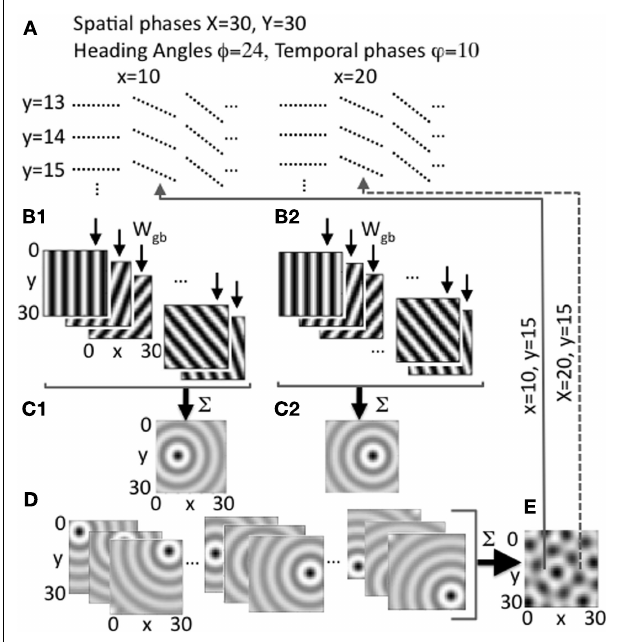
FIGURE 2 | Heading angle input across the full range of spatial phases. (A) Each spatial phase ( x , y ) is coded by a heading angle array that includes 24 different heading angles with 10 different temporal phases in each heading angle. Examples show 3 out of 24 angles for individual spatial phases y = 13, 14, 15 and x = 10, 20, with 10 temporal phases (dashed lines) for each angle. (B1,B2) Examples show synaptic output to the grid cell plane from different heading angle cell groups coding 5 out of 24 angles for a single spatial phase at a single point in time t , with bands of higher amplitude synaptic input shown in black. (B1) Shows example output for a single pair of spatial phases x = 10, y = 15, and (B2) shows output for x = 20, y = 15. (C1) Sum of all heading angle output plotted at a single time t for a single spatial phase ( x = 10, y = 15).The sum over heading angles creates an amplitude pattern of circles in the grid cell plane centered on the grid cell spatial phase x = 10, y = 15. (C2) The sum of the synaptic output over all heading angles for spatial phase x = 20, y = 15. (D) Examples show synaptic output for a range of different spatial phases (left: y = 5, x = 5, 15, 25; center: y = 15, x = 5, 15, 25; right: y = 25, x = 5, 15, 25). (E) The synaptic output from heading angles is summed across all spatial phases in the grid cell plane.The example shows that differences in the relative amplitude of the heading angle input will result in a grid cell pattern. Arrows show examples of feedback from individual grid cells in the grid cell plane that project back to regulate input from heading angle cell arrays coding x = 10, y = 15 (solid line) and x = 20, y = 15 (dashed line).